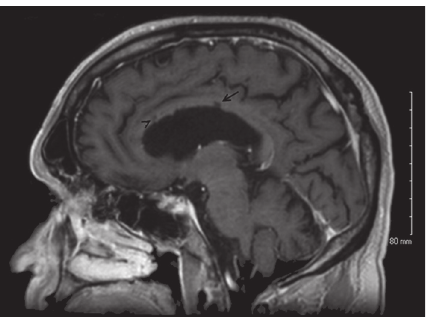
Figure 2: Sagittal T1-weighted slice at the level of the corpus callosum 12 months after treatment initiation. Note . The decreased “snowball” lesion in the body of the corpus callosum (demarcated by arrow) and relative persistence of linear “spoke” or “icicle” lesions (demarcated by an arrow